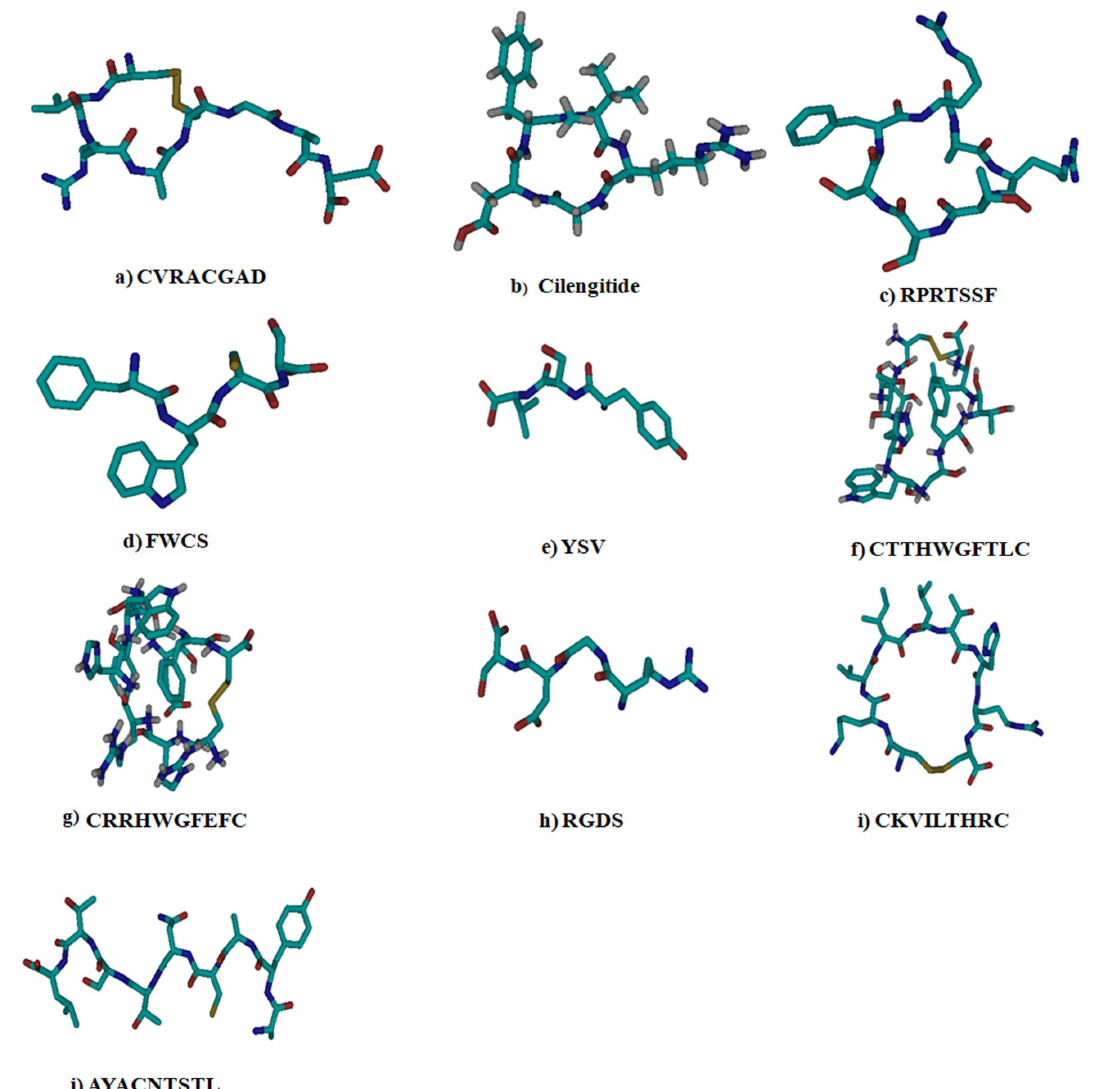
Figure 1. The di ff erent peptide-based ligands for targeting cancer-related proteins used in docking studies. Cyan blue = carbon, grey = hydrogen, deep blue = nitrogen, red = oxygen, and yellow =